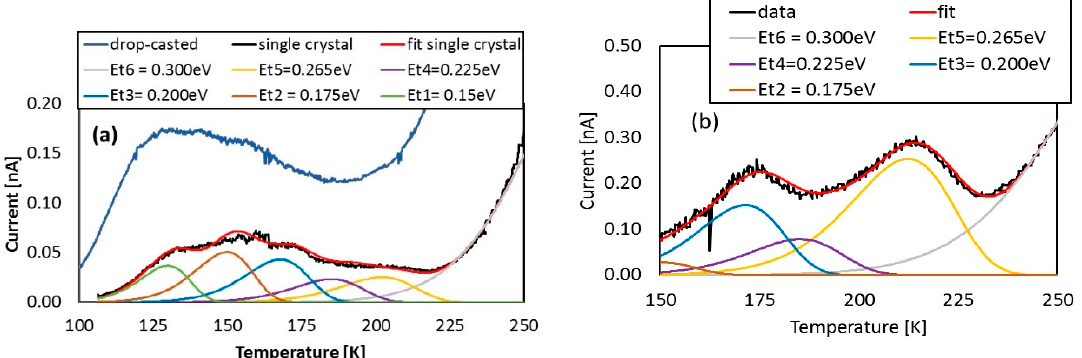
Figure 7. TSC measurement carried out on a single-crystal CsPbBr3 sample illuminated with a 400 nm LED, V b = 2 V filling at ( a ) T i = 100 K and ( b ) T i = 150 K. The best fit is carried out considering the same set of thermally stimulated components.